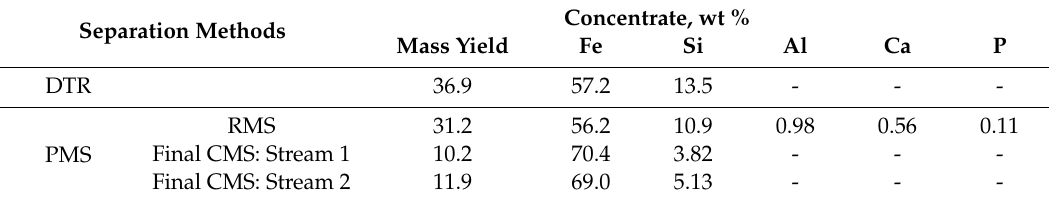
Table 5. PMS and DTR comparative studies of Flowsheet 2 (Ore feed of P 80 = 75 µ m). Concentrate, wt % Separation Methods Mass